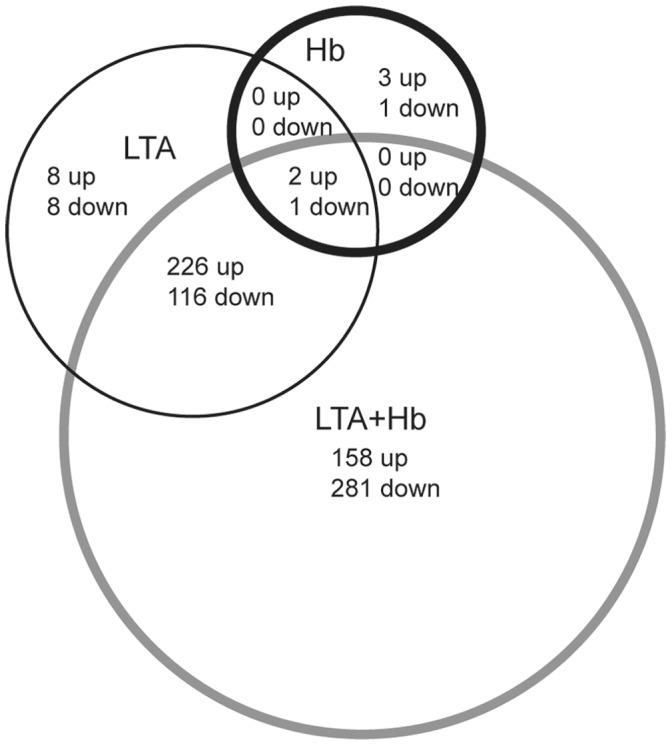
Venn diagram showing the number of differentially activated genes.HeNC2 cells were activated with LTA, Hb, LTA plus Hb or maintained in medium alone and RNA was obtained 6 hours post-treatment. Differentially expressed genes are defined as those with a GCOS-generated detection value >0.05 for at least the experimental value, a t test p value of <0.05 and a 1.5-fold or greater change between the experimental value and the medium control. These differentially expressed genes are listed in Supplemental Tables 2–4.